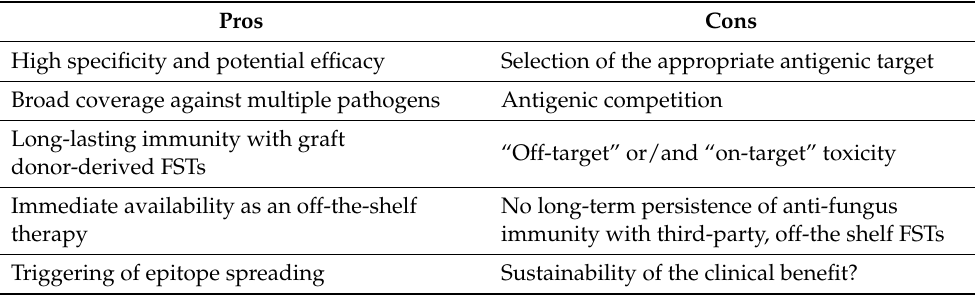
Table 2. Advantages and considerations of adoptive immunotherapy with